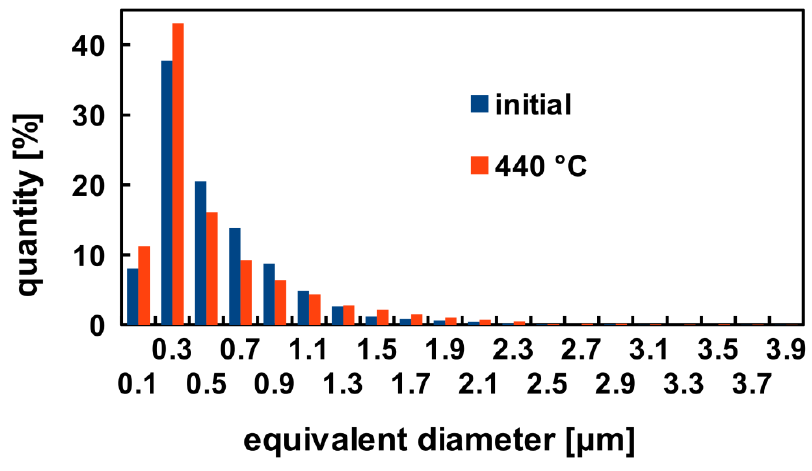
Figure 3. Distribution of particles size in the F0 specimen in the initial state and after step-by-step annealing up to 440